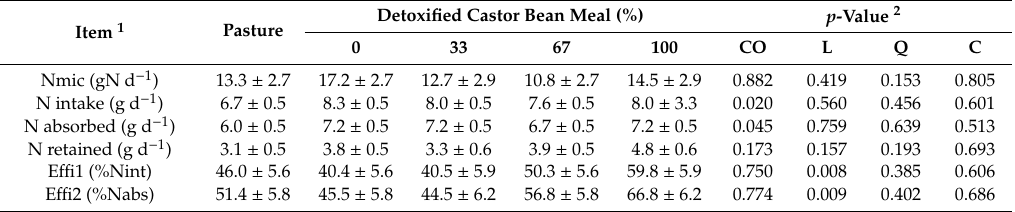
Table 9. Nitrogen balance of lambs (mean ± SD) supplemented with or without castor bean meal via a creep-feeding method.